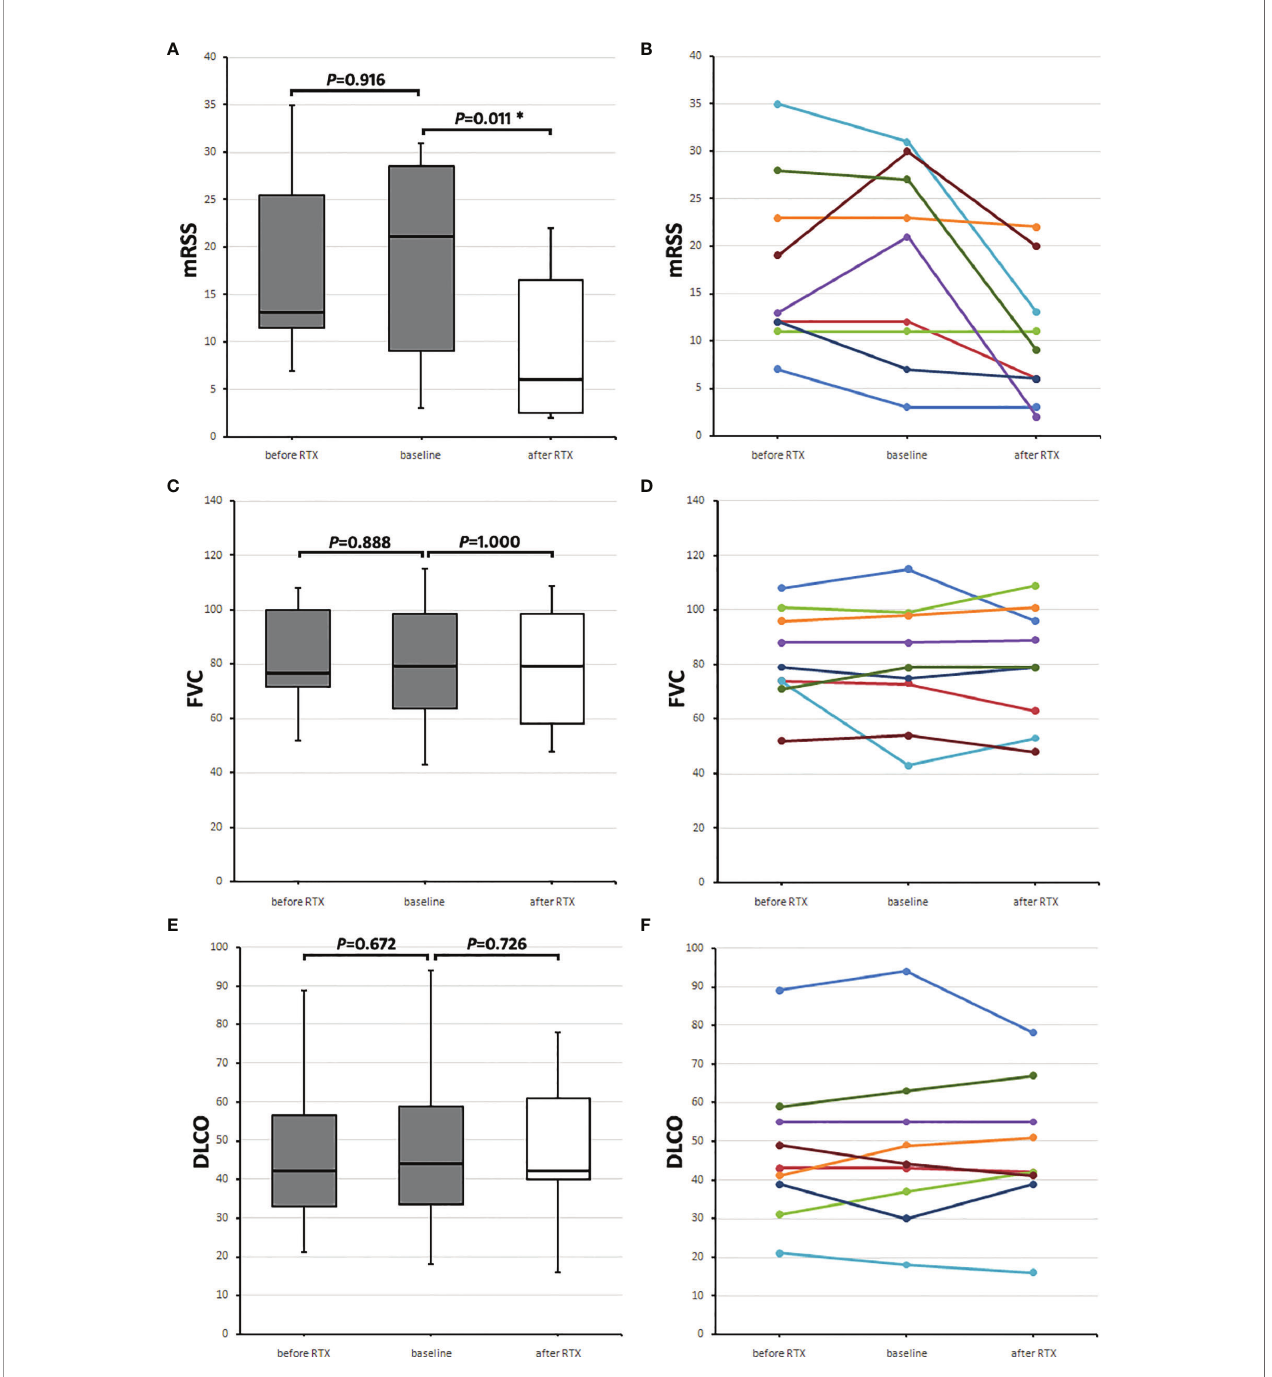
FIGURE 2 | Course of skin and lung parameters of the nine SSc patients receiving rituximab (RTX) after aHSCT. Values before RTX (before RTX, gray boxes) are shown, and baseline values (gray boxes) were taken when RTX was initiated and follow-up values (after RTX, white boxes) 2 years later. (A) Median modi fi ed Rodnan skin score (mRSS) and (B) mRSS values of each of the nine RTX receivers. (C) Median forced vital capacity (FVC) in percentages of predicted and (D) individual FVC values of each patient. (E) Median diffusion capacity for carbon monoxide (DLCO) in percentage of predicted and (F) individual DLCO values of each patient. Box plots show medians with interquartile range, whiskers indicate minimums and maximums; *Signi fi cant ( p < 0.05) difference compared to baseline in a Wilcoxon signed-rank